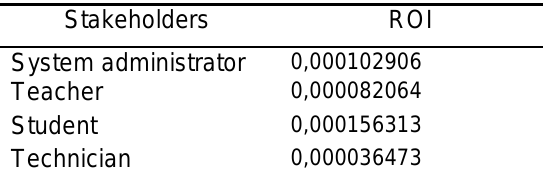
Table 14: The return on investment of the Web